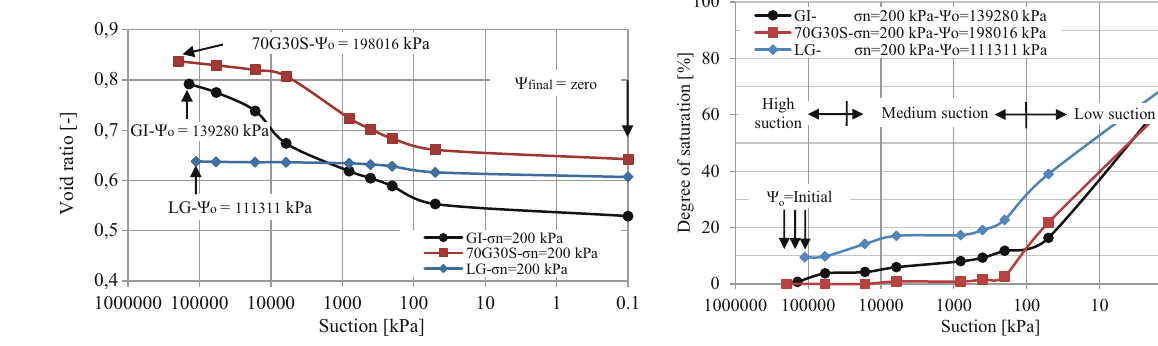
Figure 4: Variation of the void ratio with suction of the ( CN - SD ) wetting test.